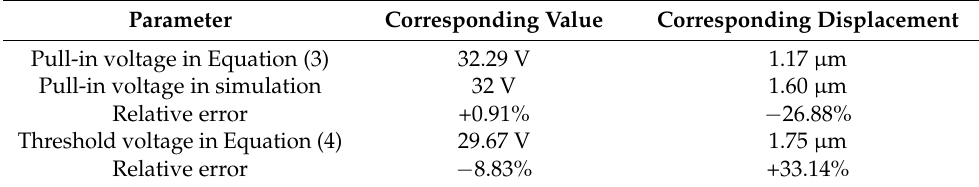
Figure 5. Relationship between displacement and voltage. Table 2. Comparison between pull ‐ in voltage and threshold voltage.